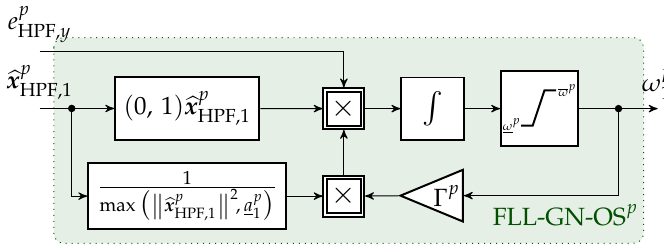
Figure 3. Frequency Locked Loop with Gain Normalization and Output Saturation